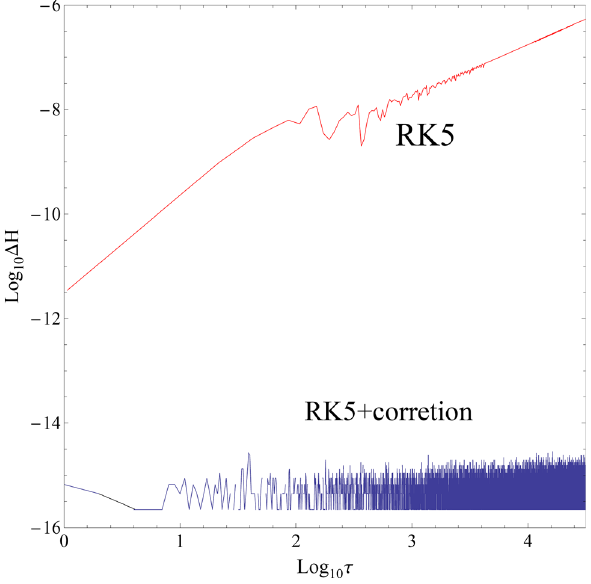
Fig. 1 The energy errors (cid:8) H with time computed by RK5 and the velocity-correction method (RK5+Correction) in the Schwarzschild– Melvin black hole